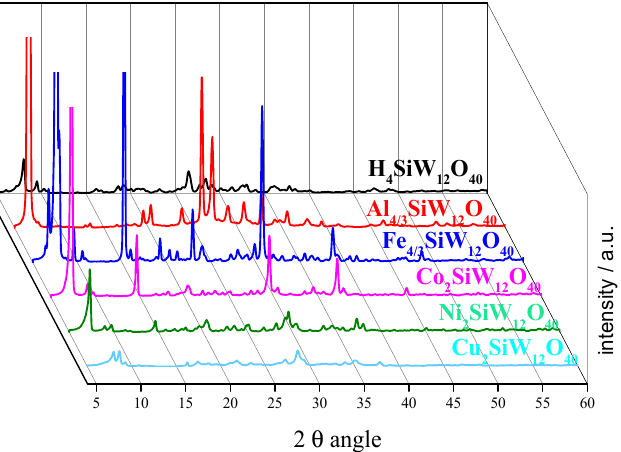
Figure 5. Primary, secondary, and tertiary structures of Keggin anion.